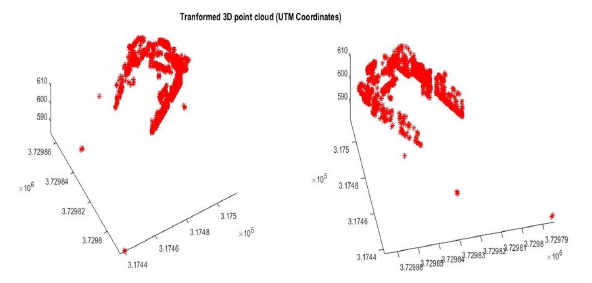
Figure 10. Transformed point